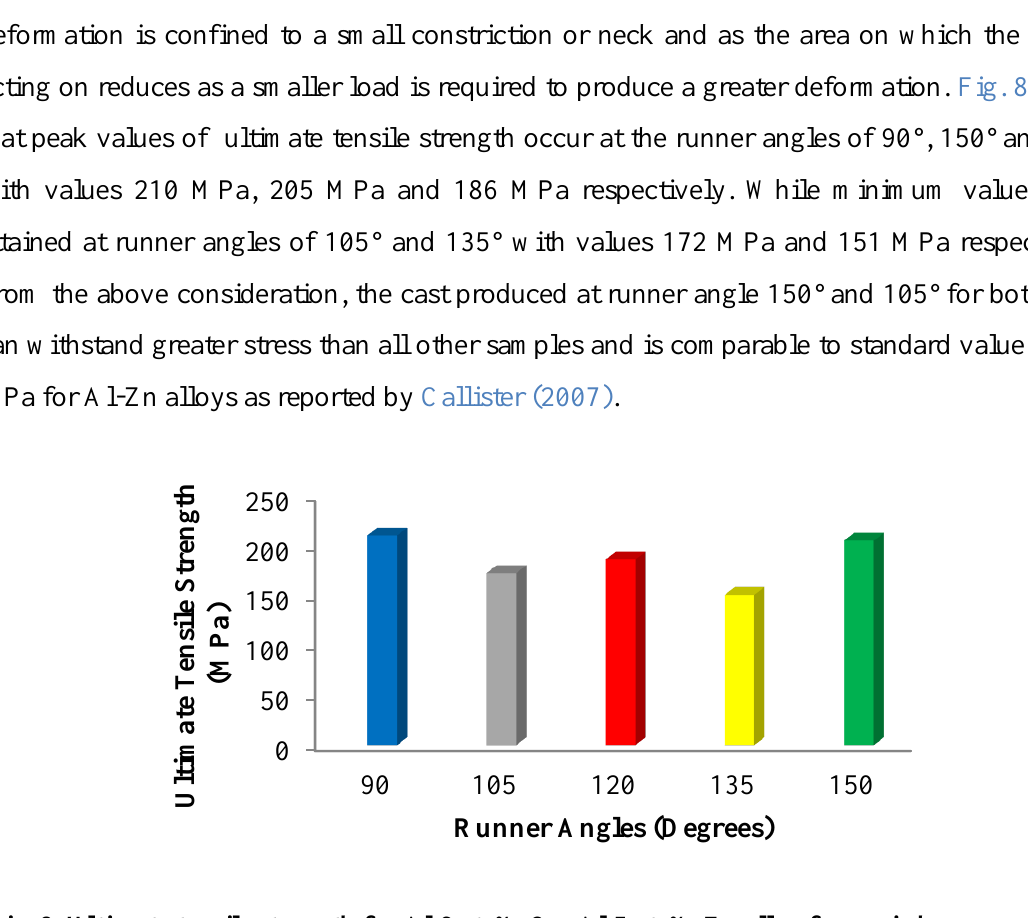
Fig. 8. Ultimate tensile strength for Al 6wt. % Cu, Al 5wt. % Zn alloy for varied runner